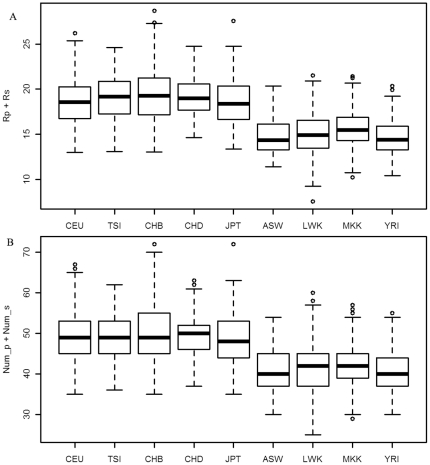
The genetic risk on population-shared and subpopulation-shared SNPs in catabolic process.Rp+Rs (subplot A) is the sum of harmful probabilities on population-shared and subpopulation-shared SNPs, and Num_p+Num_s (subplot B) is the total number of mutations on population-shared SNPs. Genetic risk (Rp+Rs in subplot A) and the sum of mutation number (Num_p+Num_s in subplot B) at population- and subpopulation-shared SNPs on candidate genes of coronary heart disease in human groups.